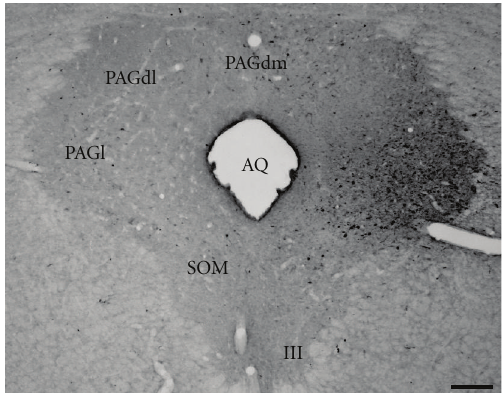
Figure 1: Brightfield photomicrograph illustrating the appearance of Fluorogold (FG) injection site in experiment PAGlFG15. Scale bar = 200 µ m